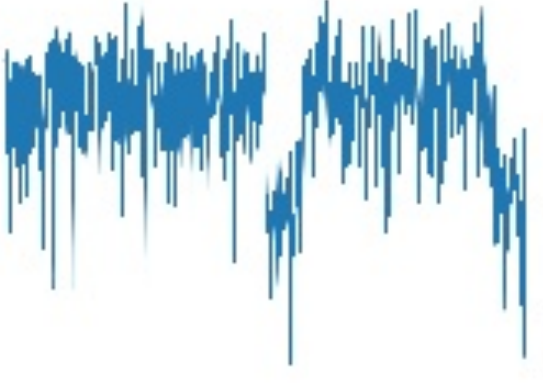
Figure 14. Input Image AR Mode